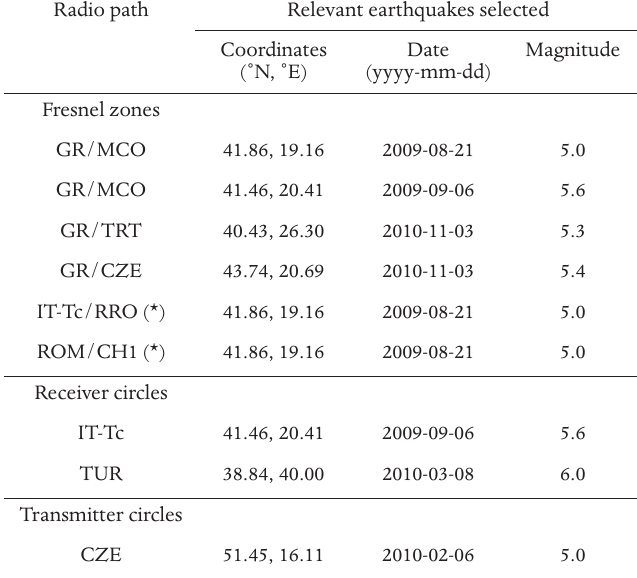
Table 2. Earthquakes selected according to the requirements indicated in